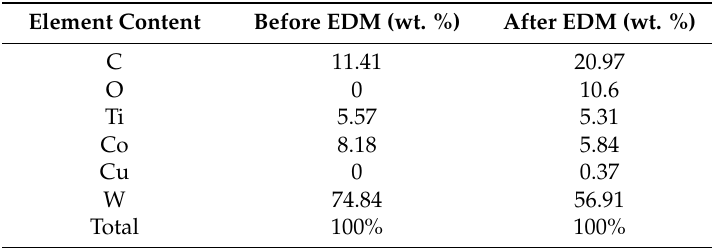
Figure 1. Micrographs of the microholes on the carbide surface: ( a , b ) a sample embedded without CaF 2 for sliding friction test and for cutting test, ( c ) enlarged micrograph corresponding to the micro-hole in ( b , d , e ) corresponding EDX composition analysis of point A and B in ( c , f ) enlarged micrograph corresponding to the micro-hole in ( c , g , h ) sample embedded with CaF 2 for the sliding wear test (SC1) and for the cutting test (SCT1). Table 2. Element compositions analysis of the cemented carbide before and after